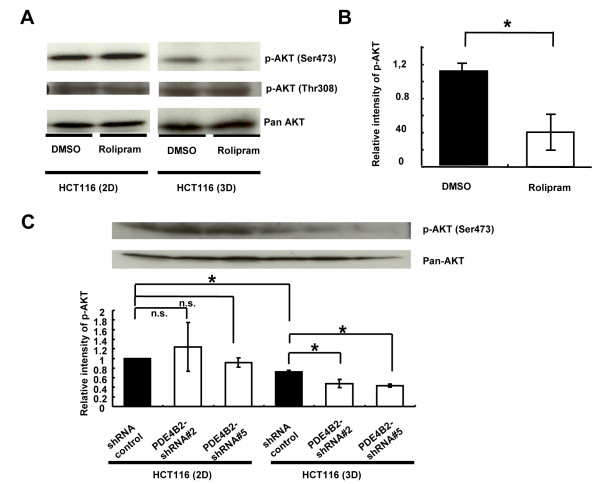
Reduction of AKT phosphorylation by rolipram in HCT116 cells grown in 3 DC.(A) Western blotting of AKT phosphorylation (p-AKT) at Ser473 and Thr308, and pan-AKT for HCT116 cells treated with DMSO alone or rolipram at day 6 in 2-D or 3-D culture. (B) The quantitative analyses of the level of p-AKT (Ser473) in HCT116 cells treated with DMSO alone or rolipram at day 6 in 3 DC. White bar represents the relative intensity of the signal for HCT116 cells treated with rolipram, normalized by the signal for HCT116 cells treated with DMSO alone (black bar). *, P < 0.01. (C) Upper panel shows western blotting of p-AKT (Ser473) and pan-AKT for HCT116 cells stably transfected with control shRNA or PDE4B2-shRNAs at day 6 in 2-D or 3-D culture. Lower panel shows the quantitative analyses of the level of p-AKT in HCT116 cells stably transfected with control shRNA or PDE4B2-shRNAs at day 6 in 3 DC. White bar represents the relative intensity of the signal for HCT116 cells stably transfected with PDE4B2-shRNAs, normalized by the signal for HCT116 cells stably transfected with control shRNA (black bar). *P < 0.05.